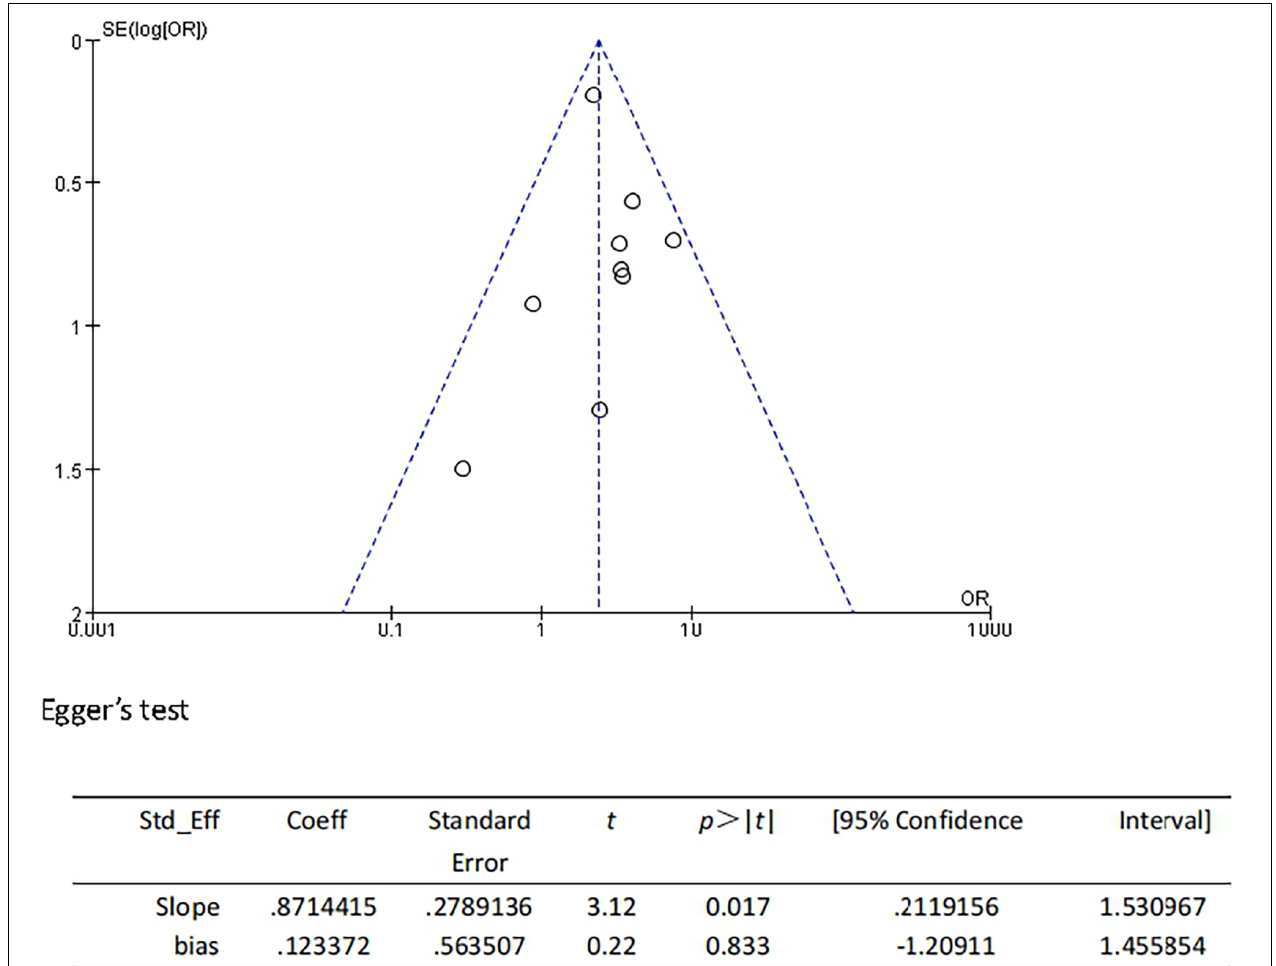
FIGURE 7 | Funnel plot and Egger’s test of studies evaluating the association between CSVD and